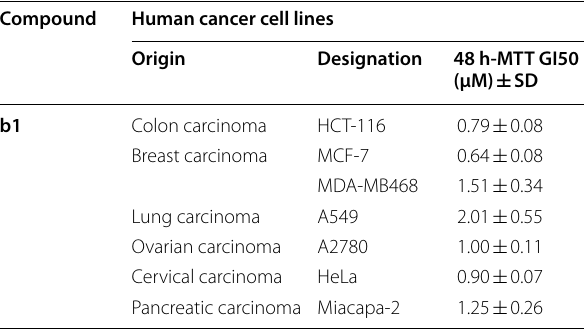
Table 15 Anti-proliferative activity of b1 in human cancer cell lines Compound Human cancer cell lines